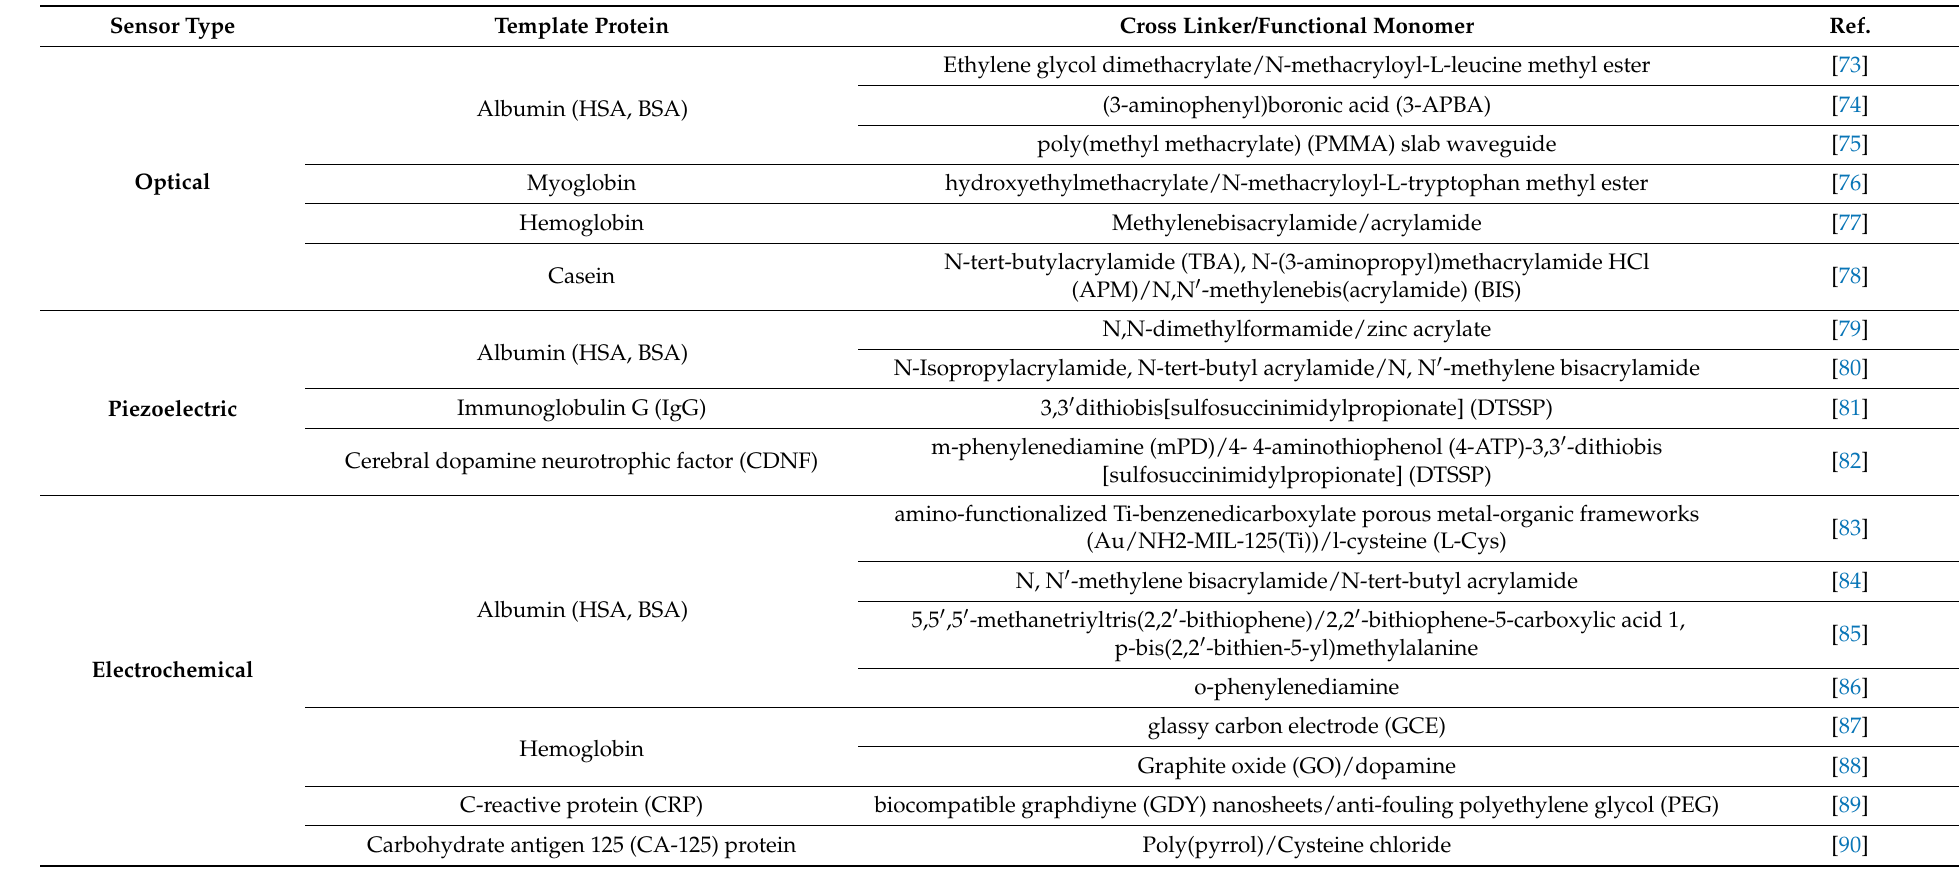
Table 1. MIP-based sensors developed for the detection of protein